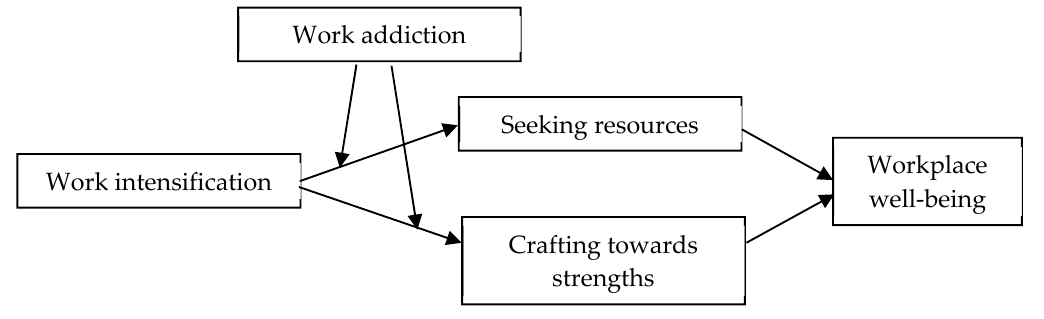
Figure 1. Hypothesized model.